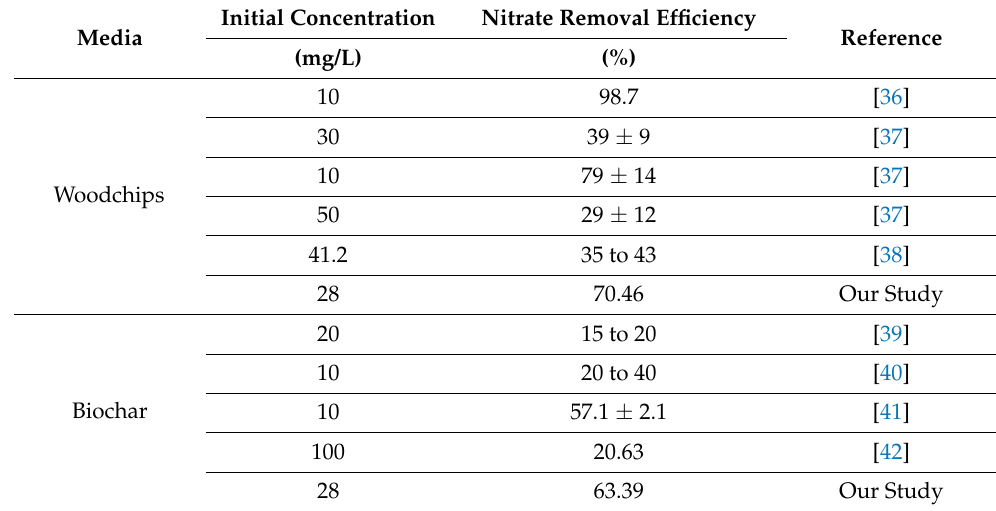
The HYDRUS 2D graphical output for nitrate concentration compared to the depth